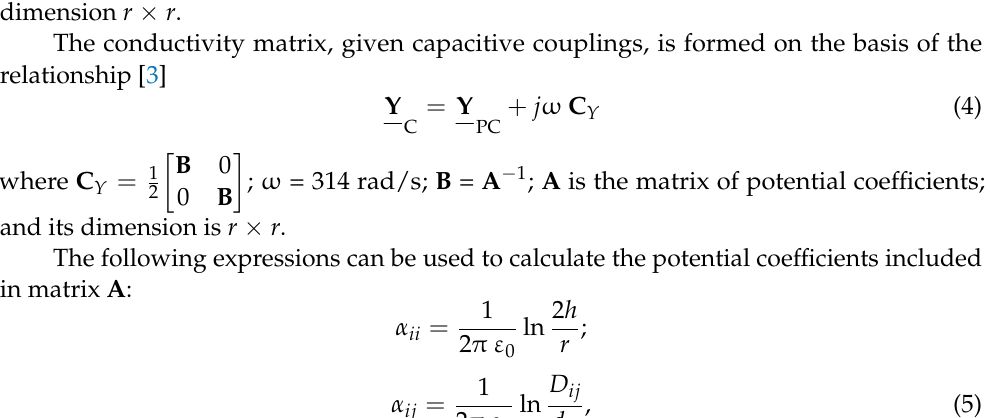
Figure 5. Original circuit of the power transmission line.